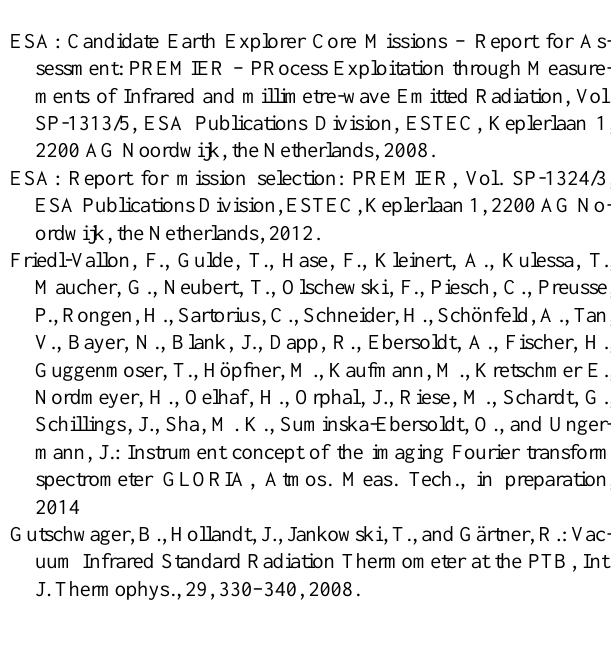
Fig. 20. The same calibration curves as in Fig. 12 are shown in red. Additionally, the deviations of the measured radiation temperatures of 2012 to the polynomial fit of 2013 are shown as a second curve in blue in each panel. (a) illustrates with PRT S124 a typical case of moderate changes, whereas (b) illustrates with PRT S210 a typical case of small